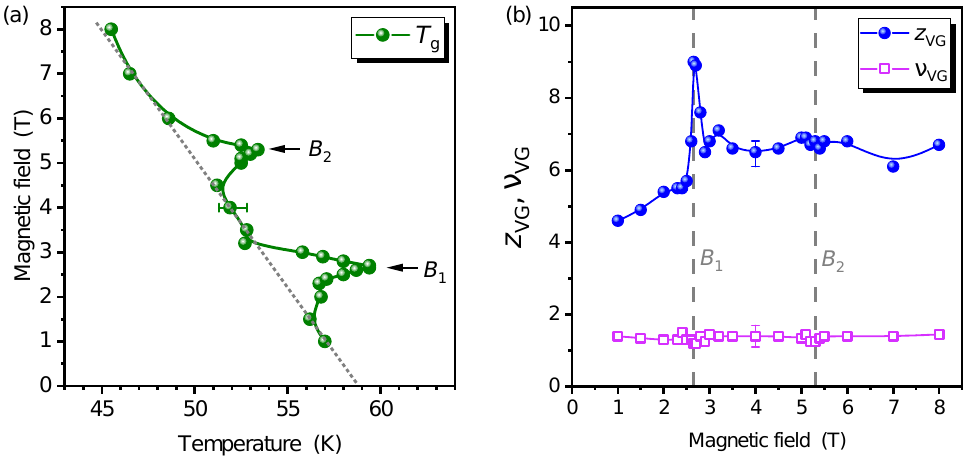
Figure 3. Scaling parameters of the nanopatterned YBCO film. The representative error bars indicate the uncertainty caused by interdependence between the fit parameters T g , z VG , and ν VG . The size of the symbols represents the uncertainty of the parameter when the other two parameters are kept fixed. Solid lines are guides to the eye. ( a ) The phase boundary between the vortex liquid and the glass phase is represented by the glass temperature T g as a function of the external magnetic field. The gray dotted line symbolizes a linear trend of T g . ( b ) Parameters from the scaling analyses according to Equation